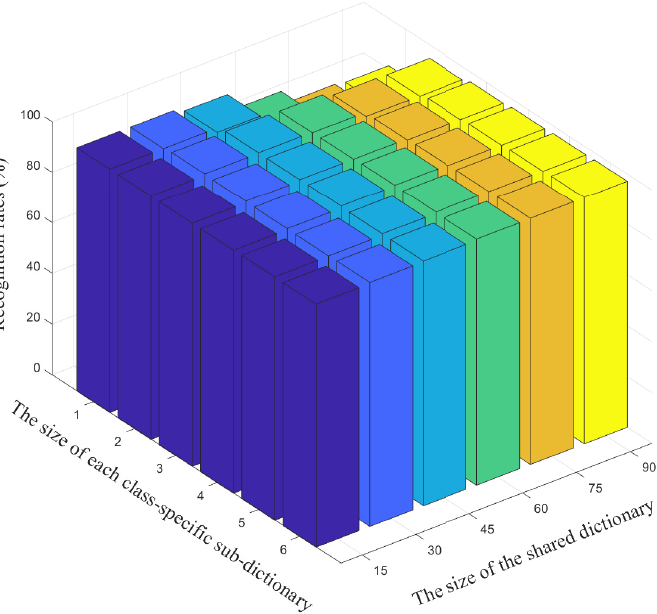
Figure 3. The recognition accuracy versus different sizes of the shared dictionary and the class-specific dictionary on the Yale face